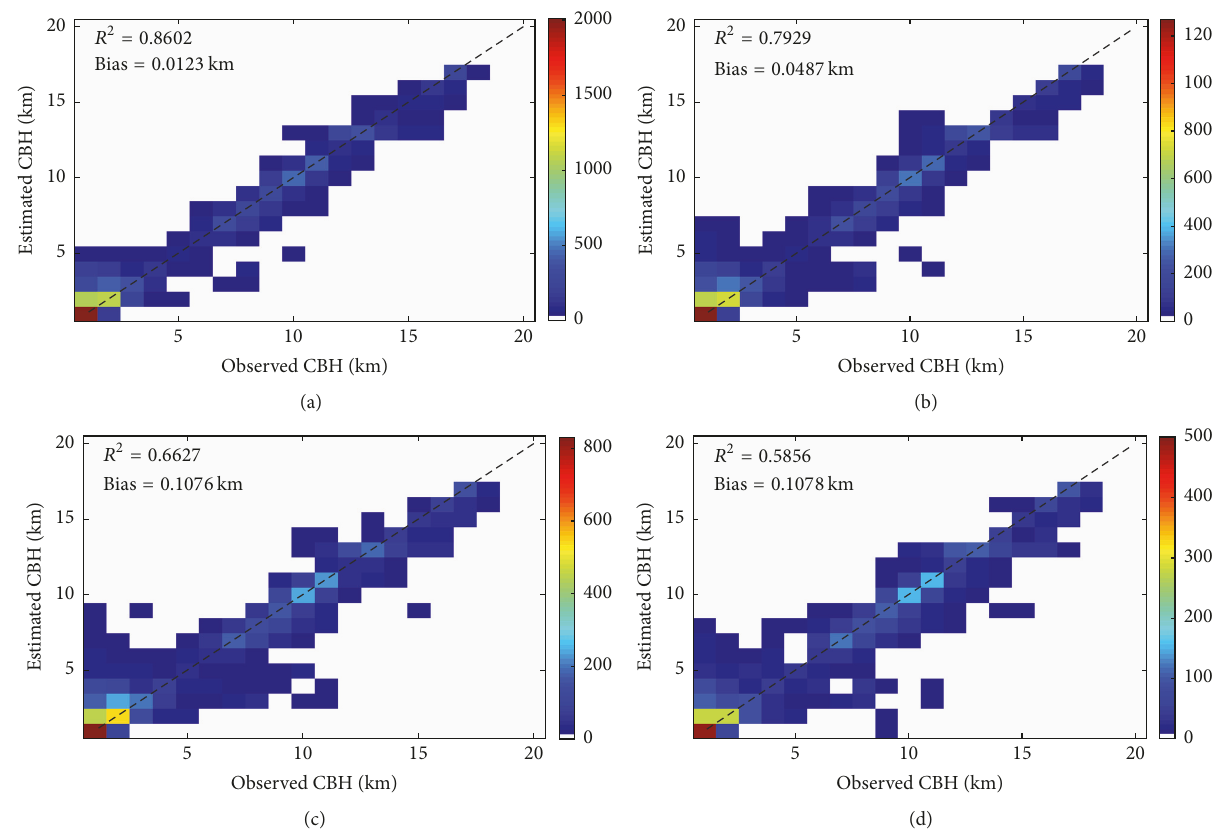
Figure 9: Scatterplots of the estimated and observed CBHs. Color bars indicate the number of data points. (a), (b), (c), (d) denote the range of separation distance between donor and recipient points which is 0 ∼ 100km, 101 ∼ 200 km, 201 ∼ 400 km, and 401 ∼ 600km,